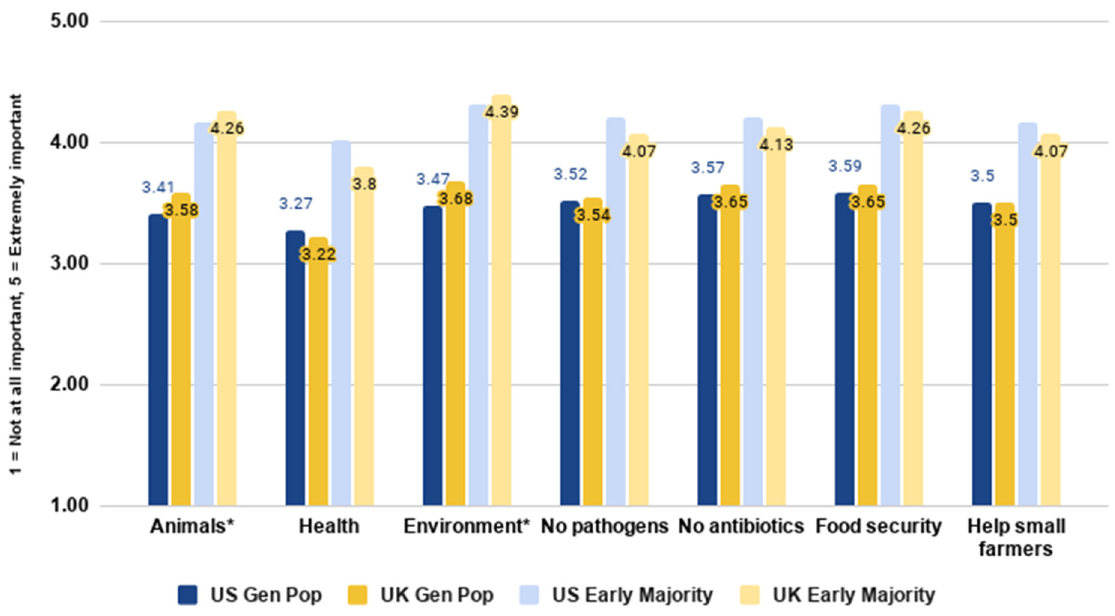
Figure 14. Importance of different reasons for adopting cultivated meat by country and segment.